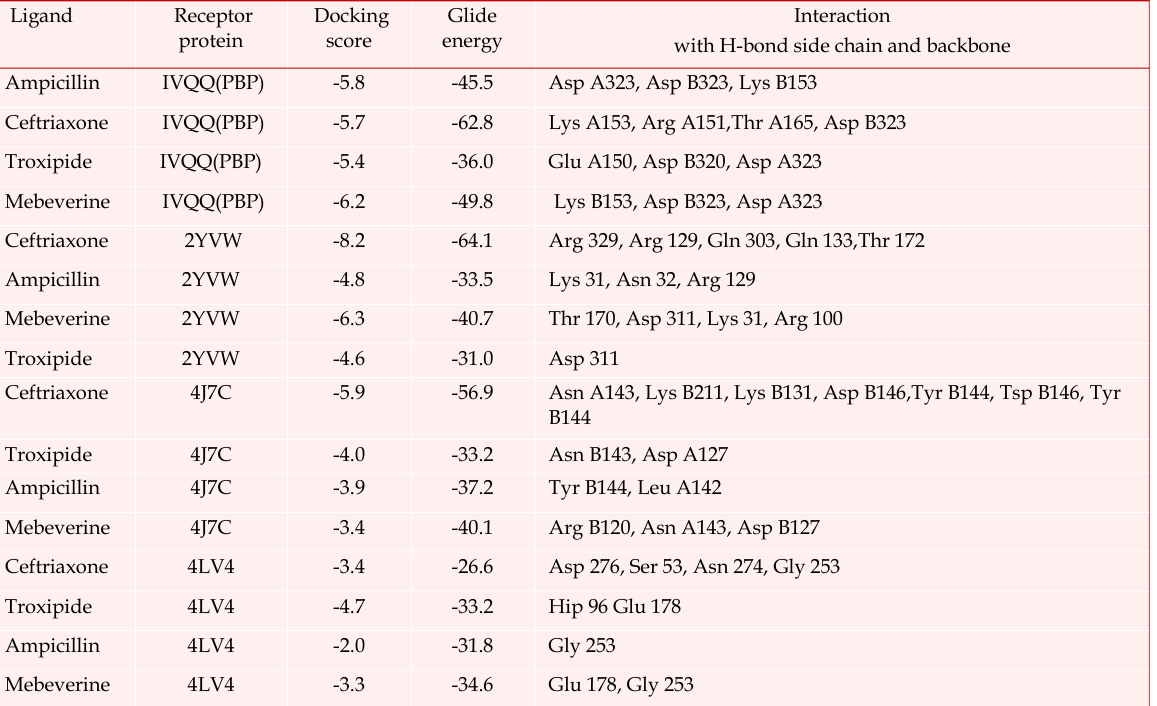
Docking studies of Troxipide and Mebeverine hydrochloride with various receptor protein* Ligand Receptor Docking Glide protein score energy